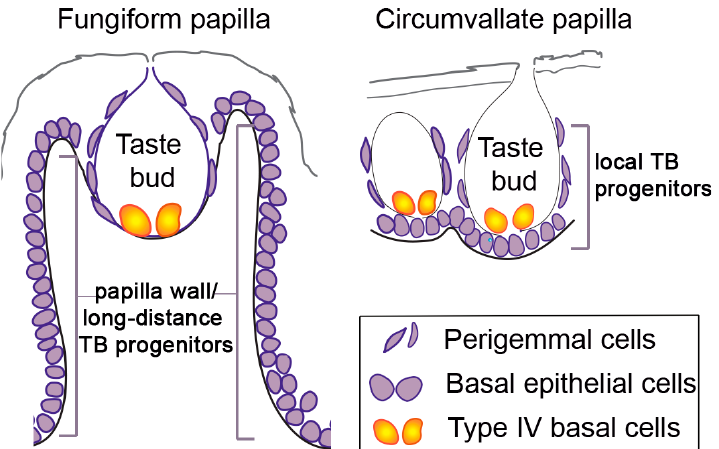
Figure 2. Taste bud (TB) progenitors. Different TB progenitor populations are demonstrated in the fungiform and circumvallate papillae: Type IV basal cells are within the TB; perigemmal cells are positioned outside of the TB; basal epithelial cells line the entire basement membrane of the papillae and are more locally positioned in the circumvallate papilla as compared to long-distance cells in the fungiform papilla wall.